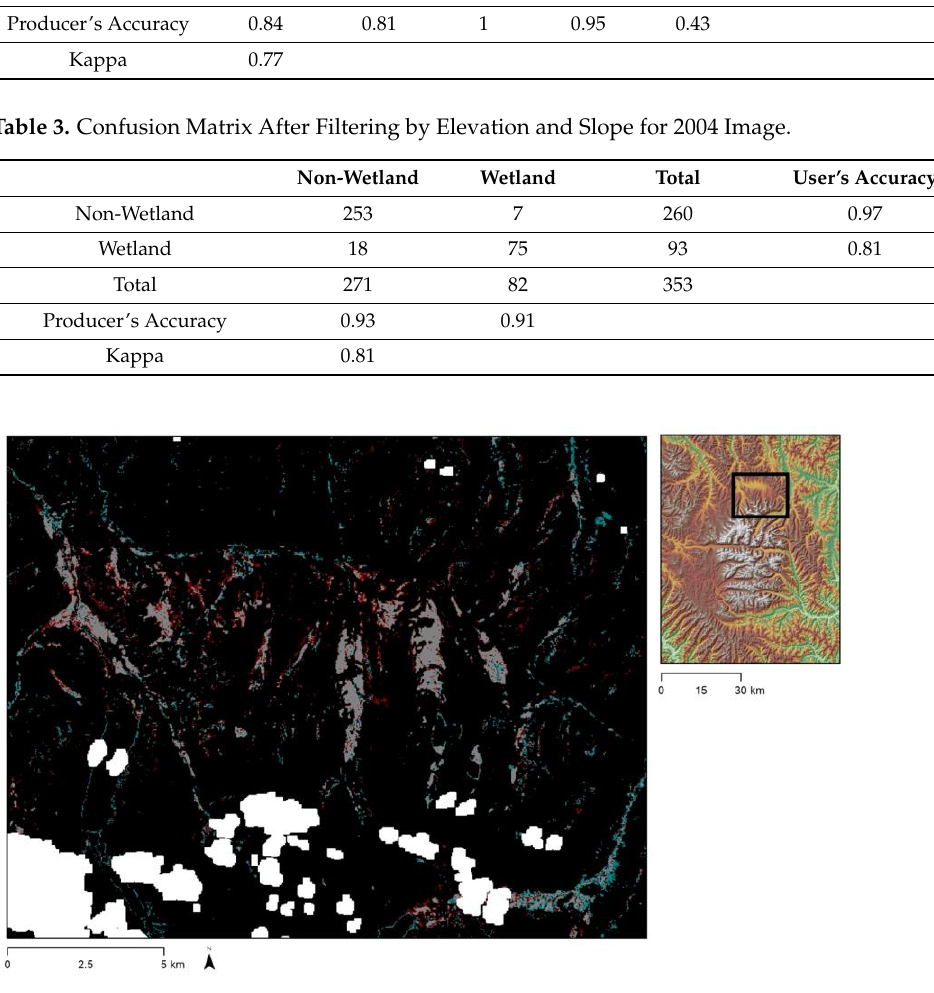
Figure 5. Composite of wetland classification results on 16 August 1996 and 25 July 2011. Grey pixels represent areas classified as wetland in both 1996 and 2011, black pixels represent areas not classified as wetland in either year. Red pixels represent areas classified as wetland in 1996 but not 2011. Cyan pixels represent areas classified as wetland in 2011 but not 1996. White pixels are regions removed due to cloud cover. Table 3. Confusion Matrix After Filtering by Elevation and Slope for 2004 Image .